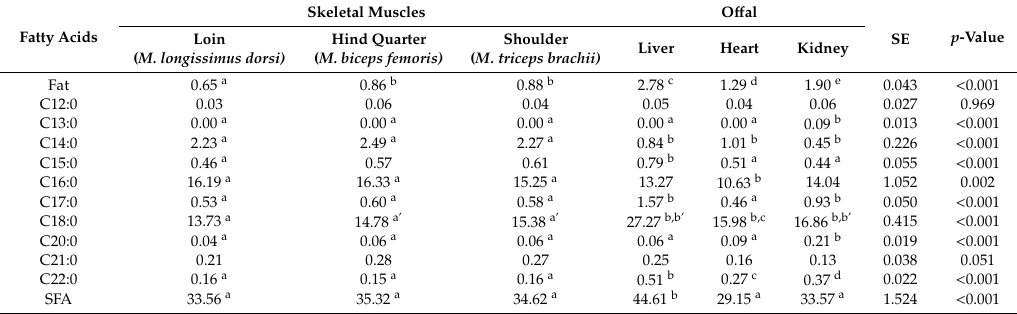
Table 1. E ff ect of tissue on fat content and saturated fatty acid (% of total FA) composition in lipids of red